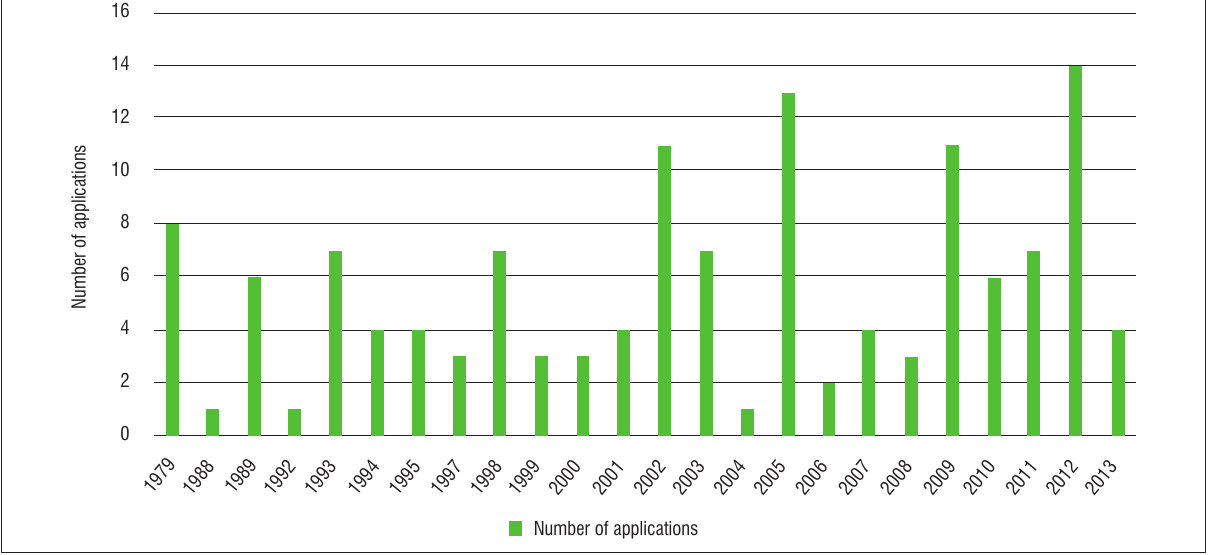
Figure 1: Annual applications for PBRs for wheat varietal improvements from 1979 to 2013, compiled from Plant Variety